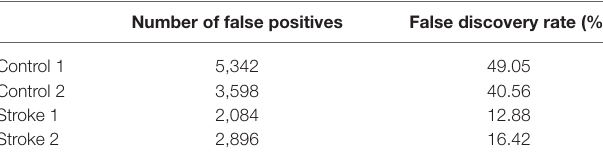
TABLE 6 | Number of false positives (FP) and false discovery rate, i.e., FP/(FP + TP) × 100%, generated by correlation metrics without involving anatomical